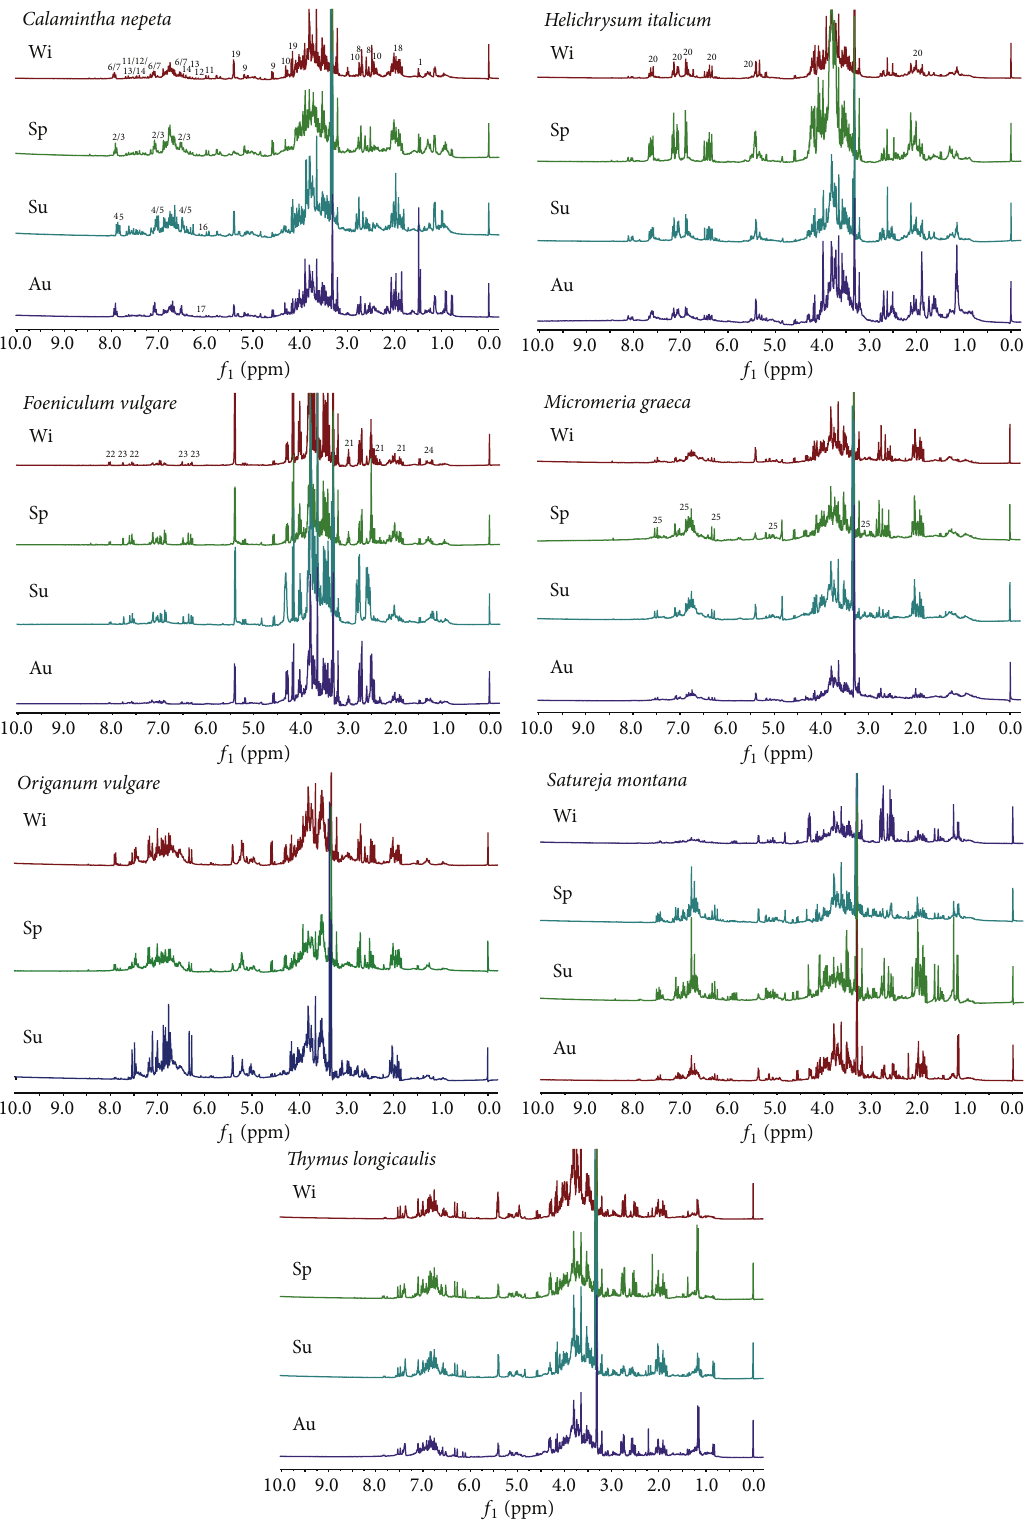
Figure 1: 1 H-NMR spectra of studied plants (Au = autumn; Sp = spring; Su = summer; Wi = winter). The main resonances of the main compounds are indicated on the spectra as follows: 1, alanine; 2, apigenin derivative 1; 3, apigenin derivative 2; 4, apigenin derivative 3; 5, apigenin derivative 4; 6, apigenin derivative 5; 7, apigenin derivative 6; 8, citric acid; 9, glucose; 10, malic acid; 11, phenylpropanoid 1; 12, phenylpropanoid 2; 13, phenylpropanoid 3; 14, phenylpropanoid 4; 15, phenylpropanoid 5; 16, phenylpropanoid 6; 17, phenylpropanoid 7; 18, quinic acid; 19, sucrose; 20, chlorogenic acid; 21, GABA; 22, kaempferol; 23, quercetin; 24, threonine; 25, rosmarinic